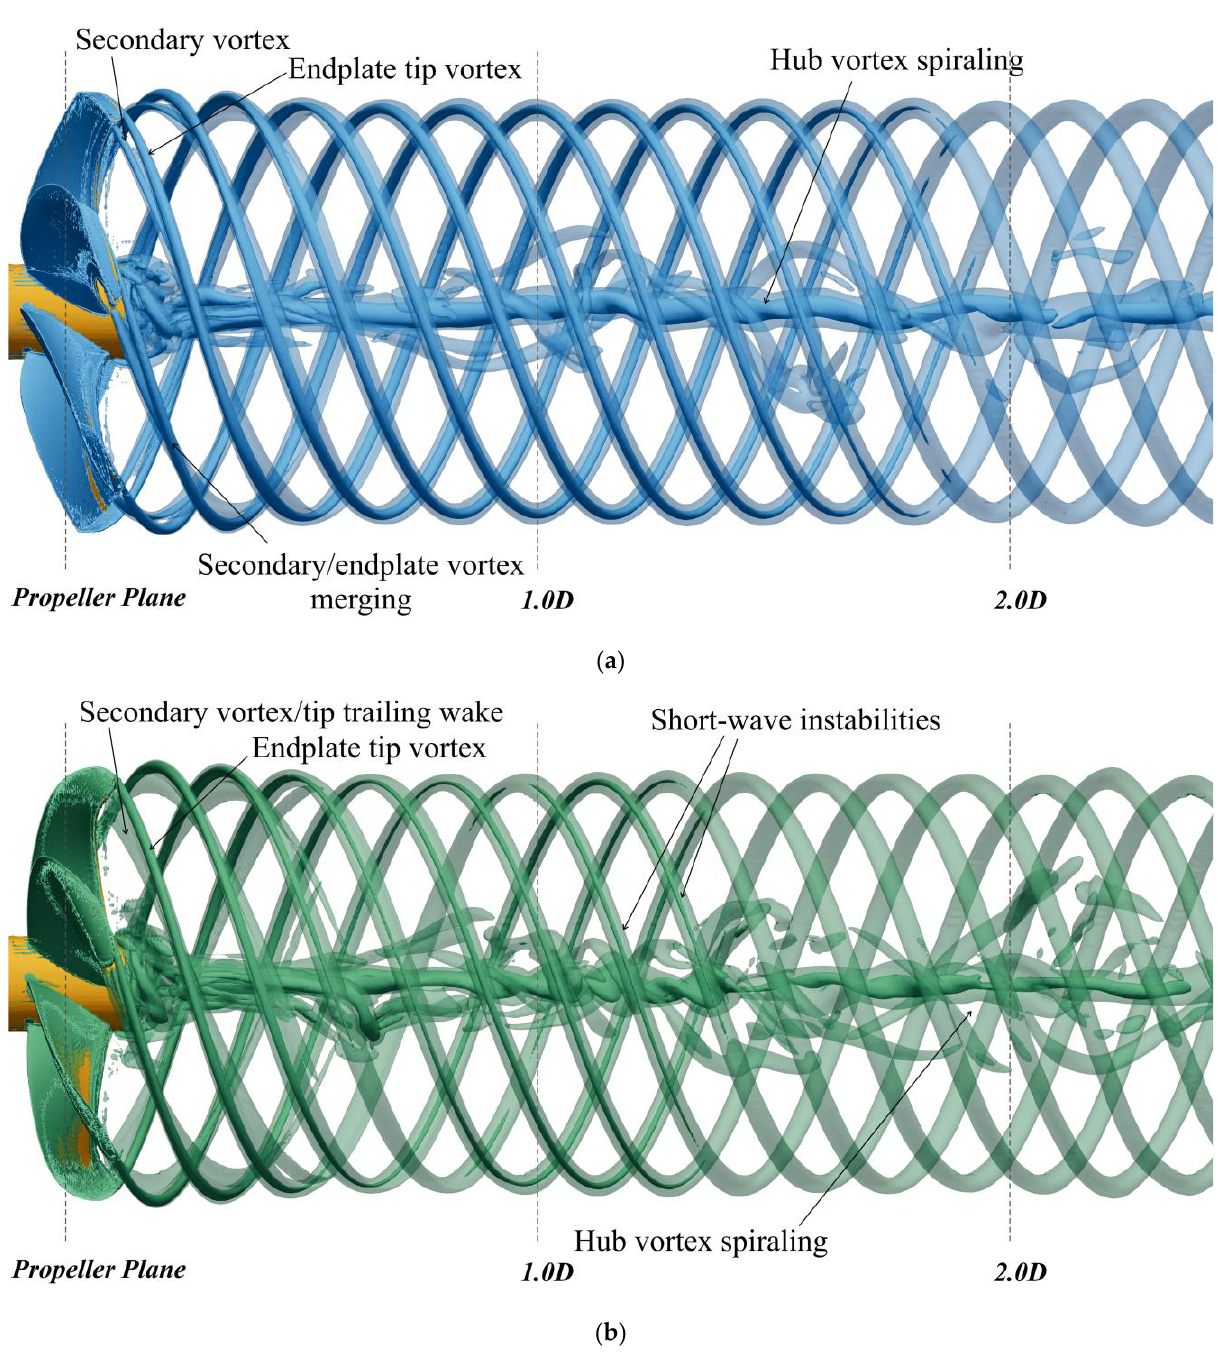
Figure 11. Isosurface of Q (5000 s −2 superimposed to Q = 50,000 s −2 ) at the design advance coefficient ( J = 0.9). Details. ( a ) Conventional CLT propeller; ( b ) New generation CLT